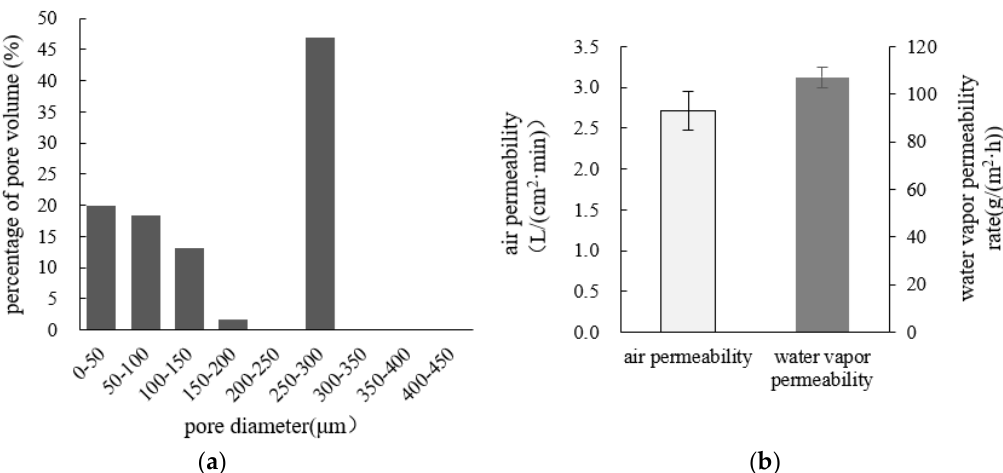
Figure 5. Pore size distribution ( a ) and permeability ( b ) of the ramie fiber/starch nonwoven film.